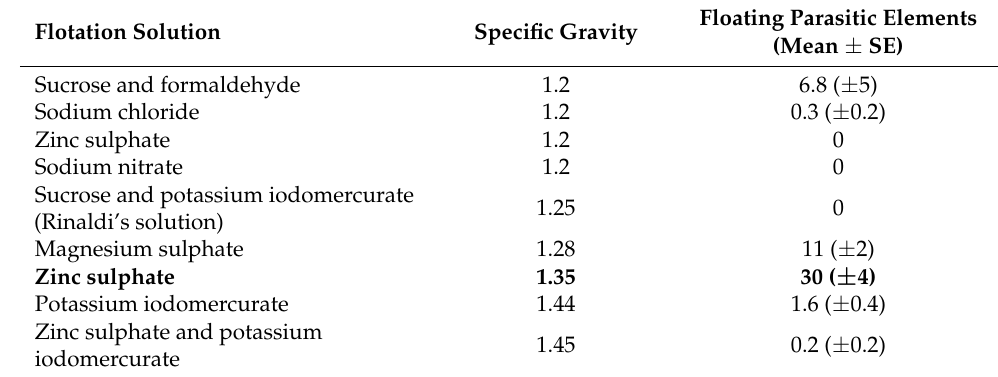
Table 2. Flotation solutions and their performance. The most appropriate solution is marked in